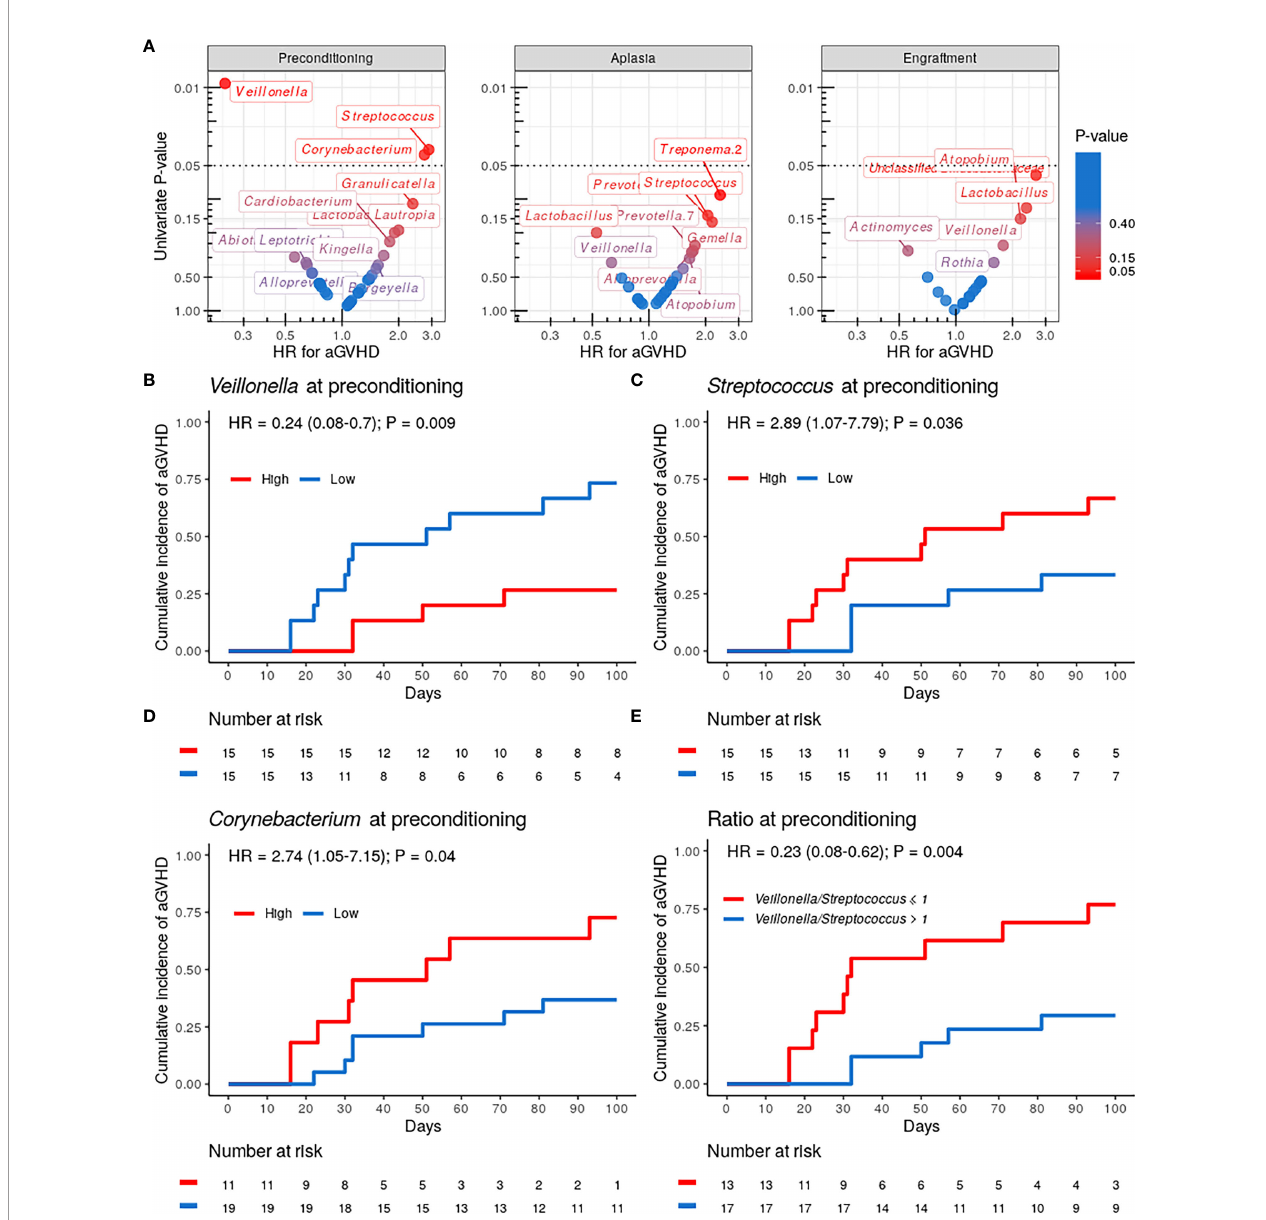
FIGURE 3 | Speci fi c genera relative abundance at preconditioning are associated with the risk of acute graft- versus -host disease (aGVHD). (A) Volcano plot for the univariate competing risk analysis for the association of aGVHD with genera relative abundance (hazard ratio vs. P-value) at preconditioning (left), aplasia (center) and engraftment (right). Only genera with ≥ 0.1% relative abundance in at least 25% of samples at a given phase were evaluated. Genera with P-value < 0.4 for the association are indicated explicitly. (B – D) Cumulative incidence of aGVHD with patients (n = 30) strati fi ed by either Veillonella (B) , Streptococcus (C) or Corynebacterium (D) relative abundance at preconditioning (High vs. Low). (E) Cumulative incidence of aGVHD with patients (n = 30) strati fi ed by Veillonella / Streptococcus relative abundance ratio at preconditioning (>1 vs. ≤